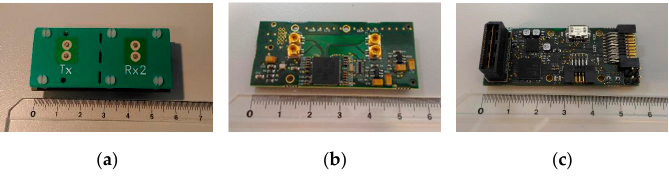
Figure 12. Ultra-wideband radar module. ( a ) Antenna board; ( b ) RF board; ( c ) digital board.